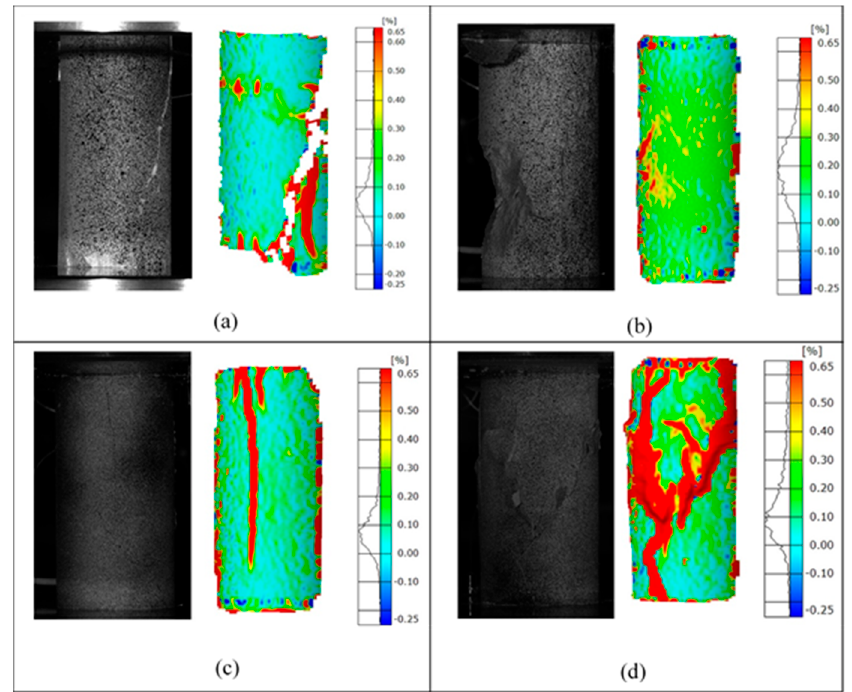
Figure 6. ARAMIS images of specimens of failure (major strain): ( a ) dry specimen; ( b ) 10% brine and 100% DOS; ( c ) 20% brine and 100% DOS; ( d ) 25% brine and 100% DOS.